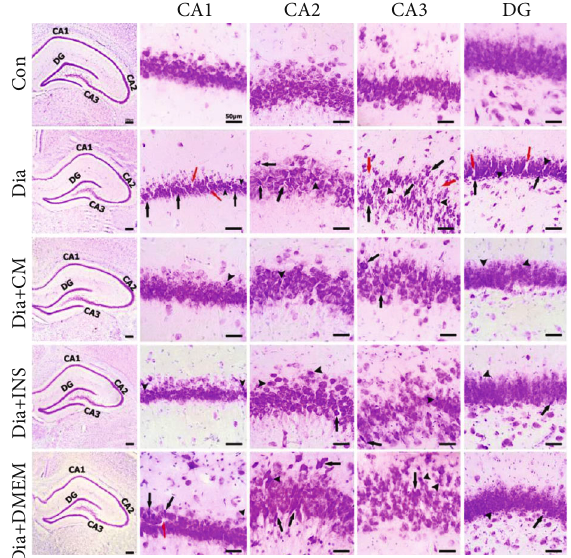
Figure 8: The representative cresyl violet-stained sections of the Cornu Ammonis (CA1, CA2, and CA3), and dentate gyrus (DG) regions in rat hippocampus of di ff erent groups. Darkened and contracted cells (black arrows), areas of cell loss (red arrows), and pyknotic nuclei (arrowheads). Con: control; Dia: diabetes; Dia +CM: WJMSC-CM-treated diabetic group; Dia +INS: insulin- treated diabetic group; Dia + DMEM: DMEM-treated diabetic